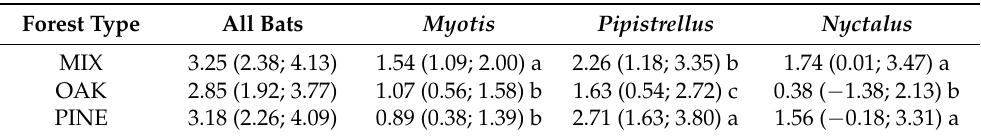
Table 5. Estimated marginal means (EMMs) and asymptotic confidence intervals (in parentheses) of bat passes in coniferous (PINE), mixed (MIX), and deciduous (OAK) forests for all bat species together and three genera of bats ( Myotis , Pipistrellus , and Nyctalus ) separately. Results are given on the log (not the response) scale. Different letters indicate statistically significant ( α = 0.05) differences between EMM computed for factor levels, as a result of post hoc Tukey